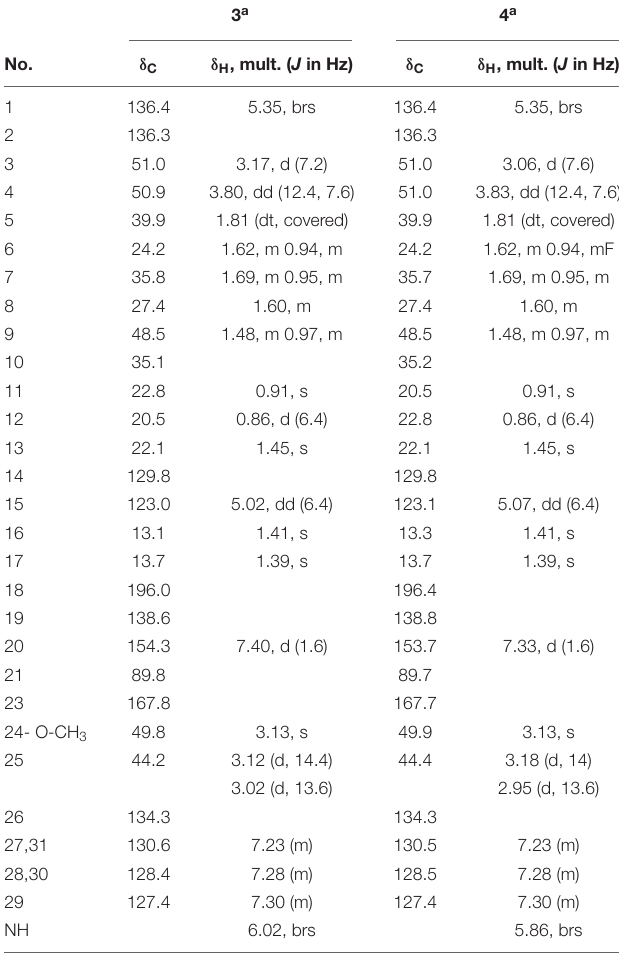
TABLE 3 | 1 H and 13 C NMR data of 3 and 4 ( δ H in ppm, J in Hz).